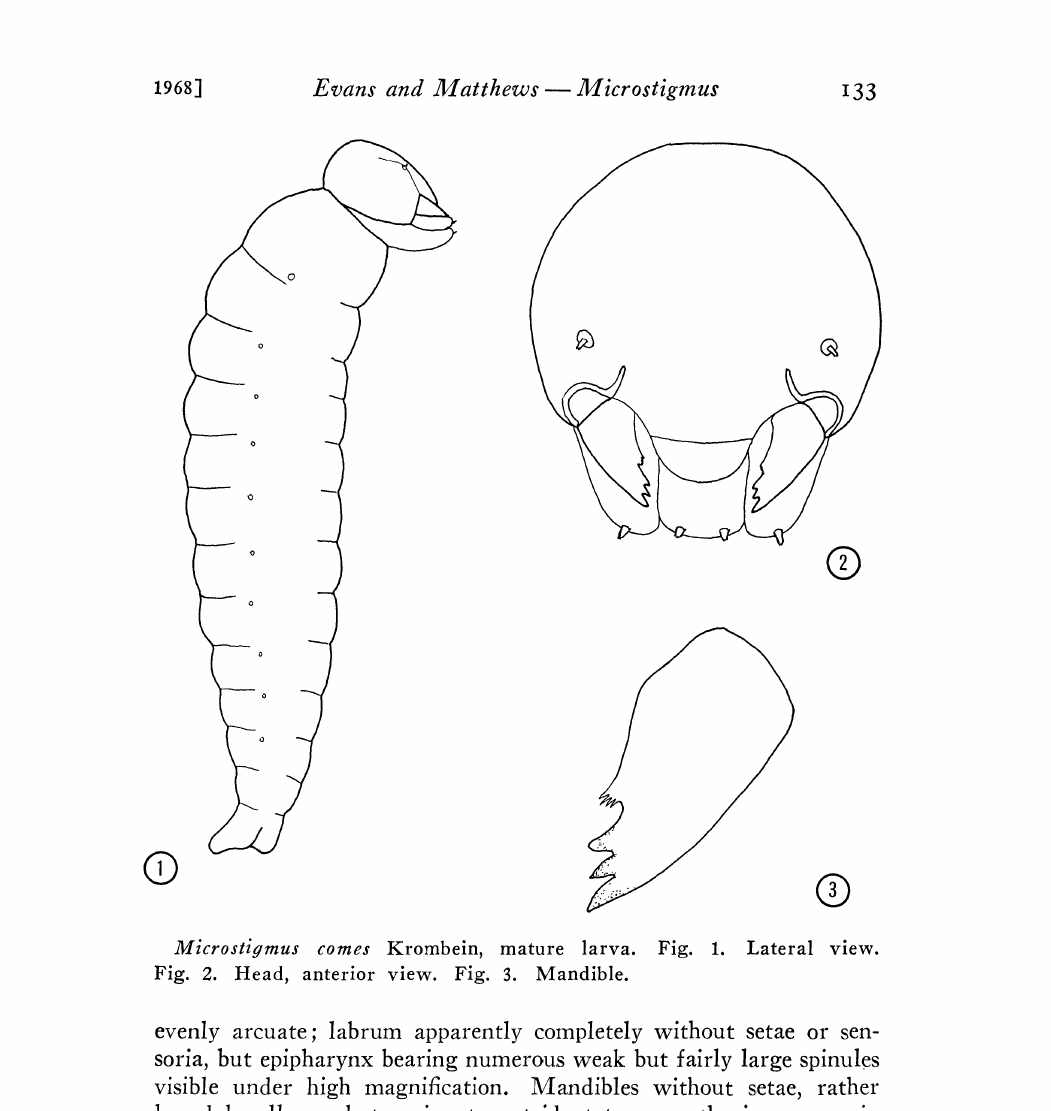
Fig. 2. Head, anterior view. Fig. 3.